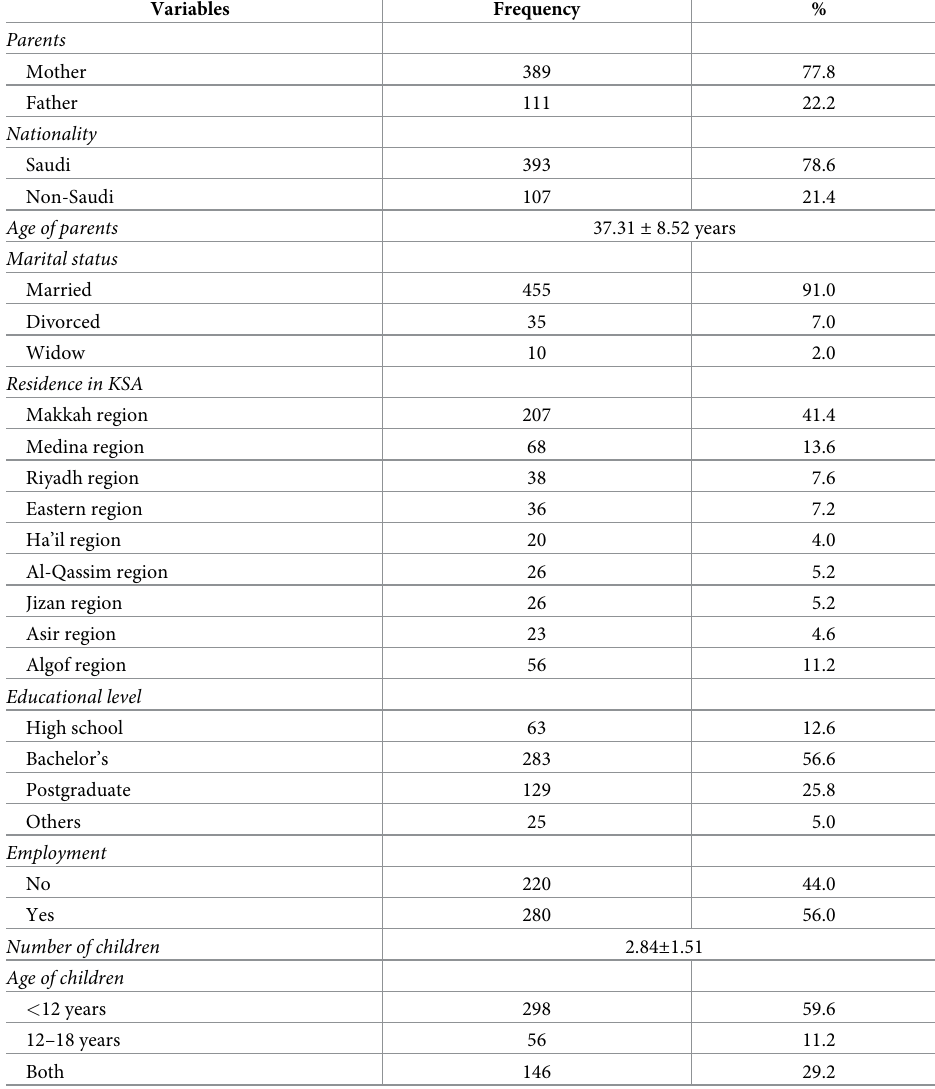
Table 1. Sociodemographic data of the participants ( n =